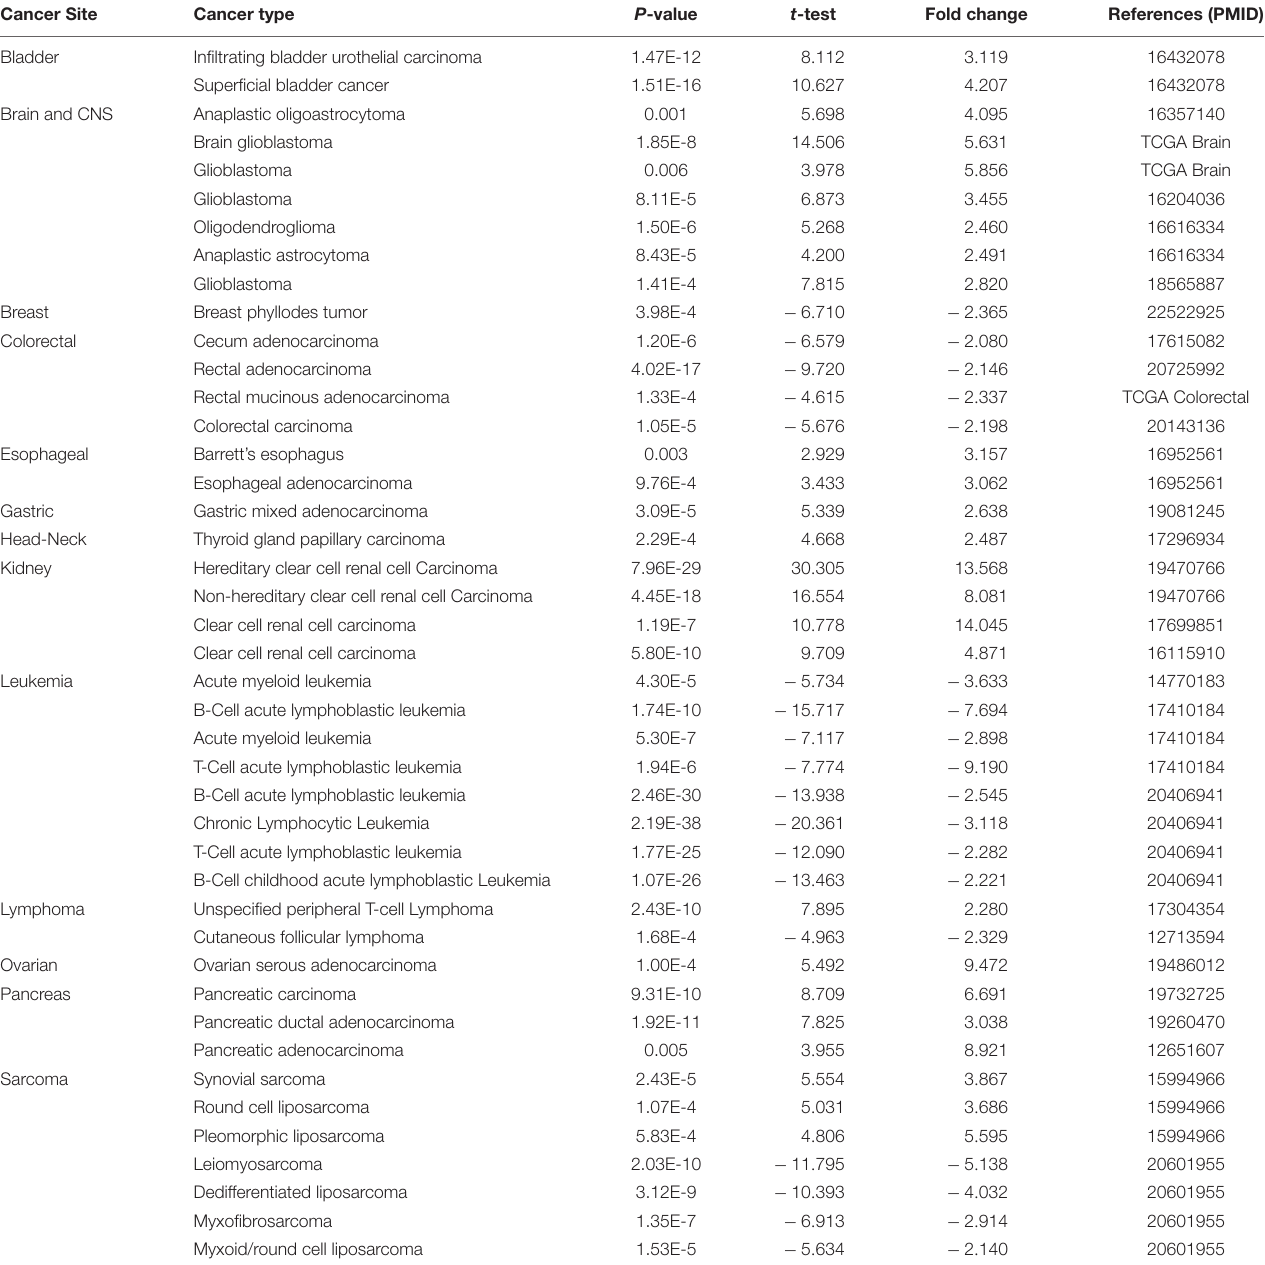
TABLE 1 | HK2 expression in cancerous vs. normal tissue in